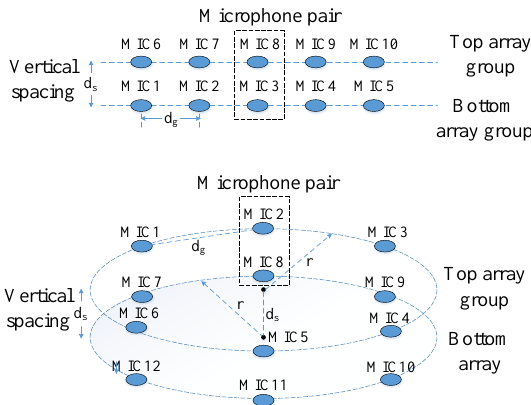
Figure 1. Microphone array structure. The upper linear array is appropriate for 2D source localization while the bottom two-layer circular array can be utilized in 3D